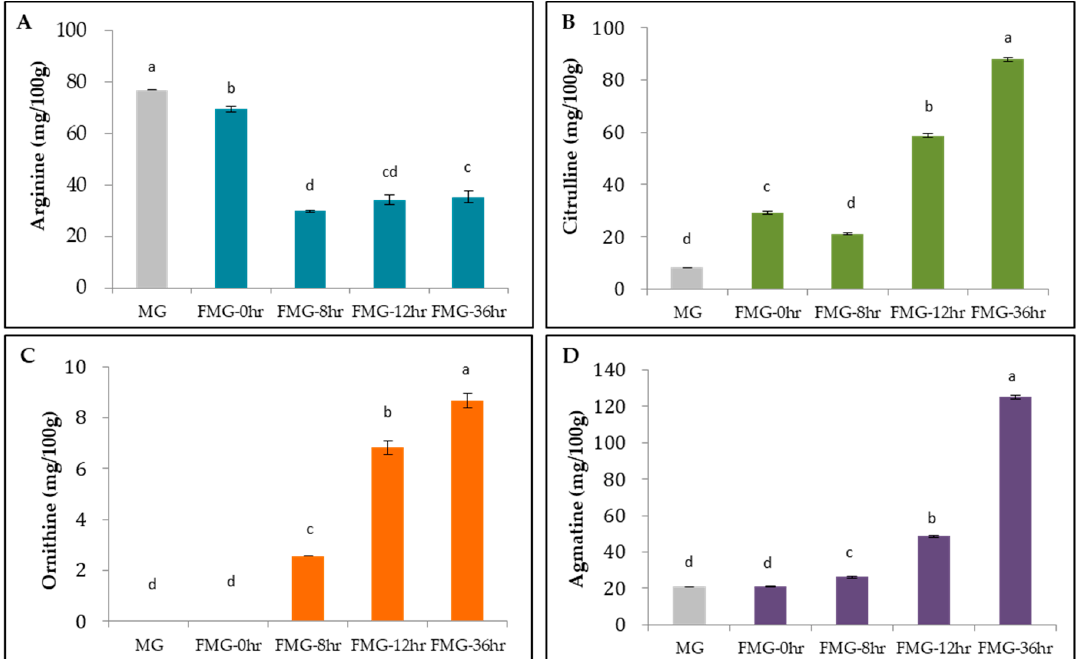
Figure 3. Arginine metabolites during fermentation. Content changes of ( A ) arginine, ( B ) citrulline, ( C ) ornithine, and ( D ) agmatine were measured using HPLC. MG, a grain mixture before steaming; FMG-0hr, a mixture of grain steamed for 30 min at 100 °C; FMG-8hr, a mixture of grain fermented for 8 h; FMG-12hr, a mixture of grain fermented for 12 h; and FMG-36hr, a mixture of grain fermented for 36 h. Data from one representative experiment of three independent experiments were presented as the mean with standard deviation of three technical replicates. Values with different letters are significantly different with p < 0.05 according to Duncan’s multiple-comparison test.